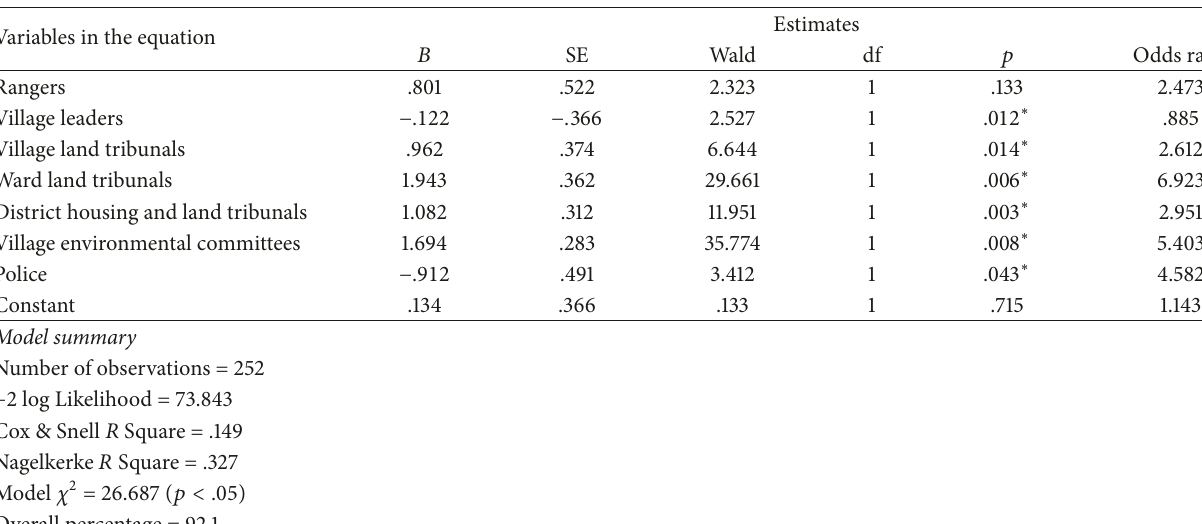
Table 7: Results of logistic regression showing perceptions on the effectiveness of conflict reconciliatory institutions. Variables in the